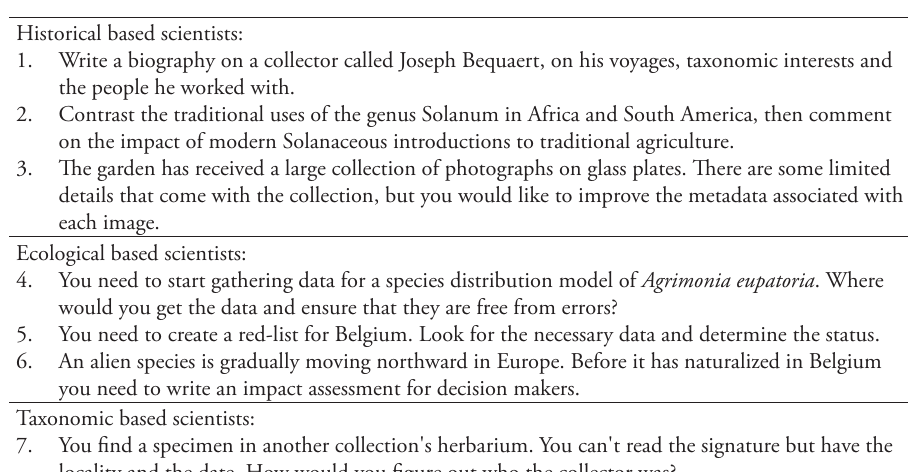
Table 1. Task scenarios presented to participants in the user requirements